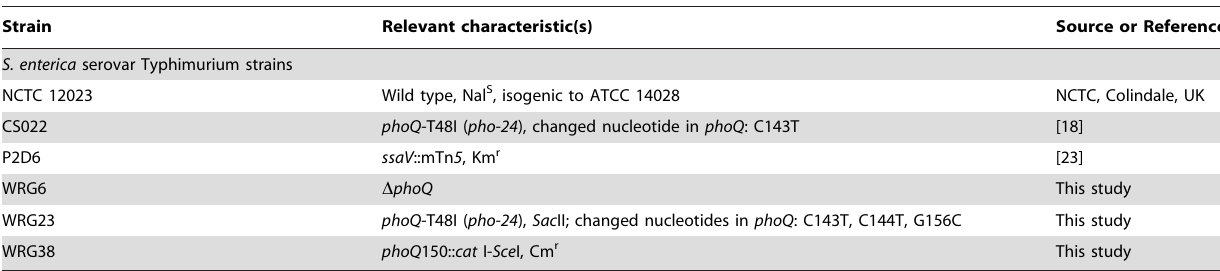
Table 3. Bacterial strains used in this study.